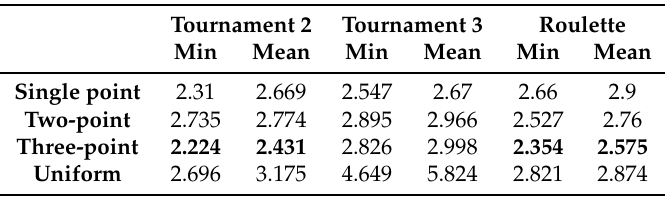
Table 4. Analysis of multiple combinations of genetic operators for the scenario proposed. Bold values shown are the minimum and mean values of the mean RMSE (m) of multiple